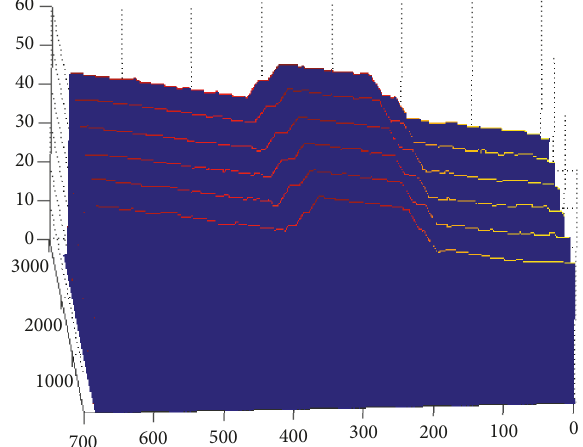
Figure 14: Laser height reconstruction.